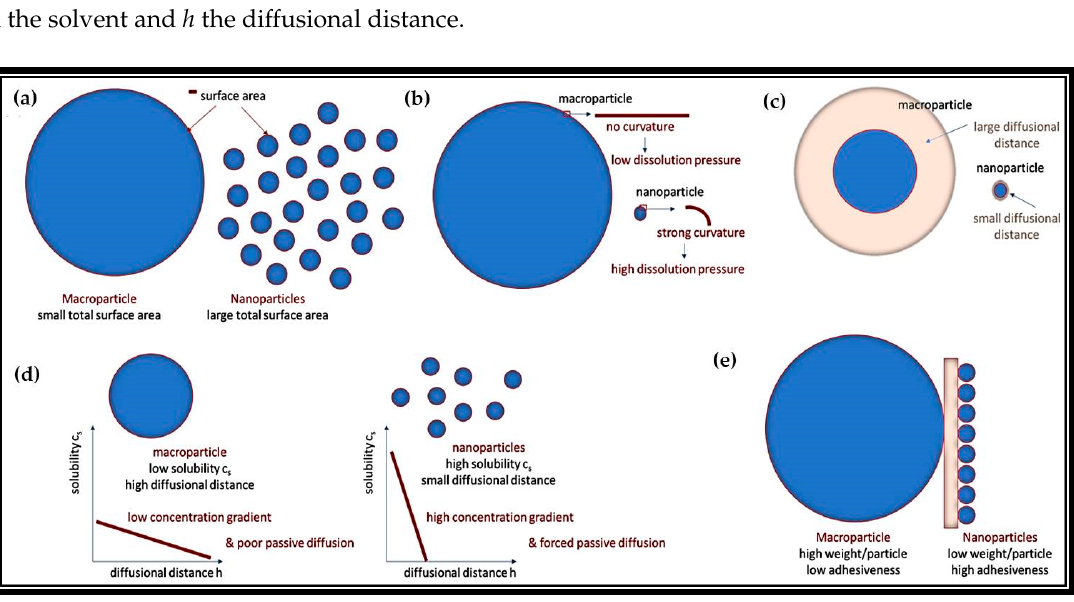
Figure 7. A schematic overview of theutilization of nanosizing techniques for turning waste into value. The activities observed for those nanosized materials are often promising, yet there is a fine balance of arguments which needs to be considered. On a positive note, nanosizing an herb or